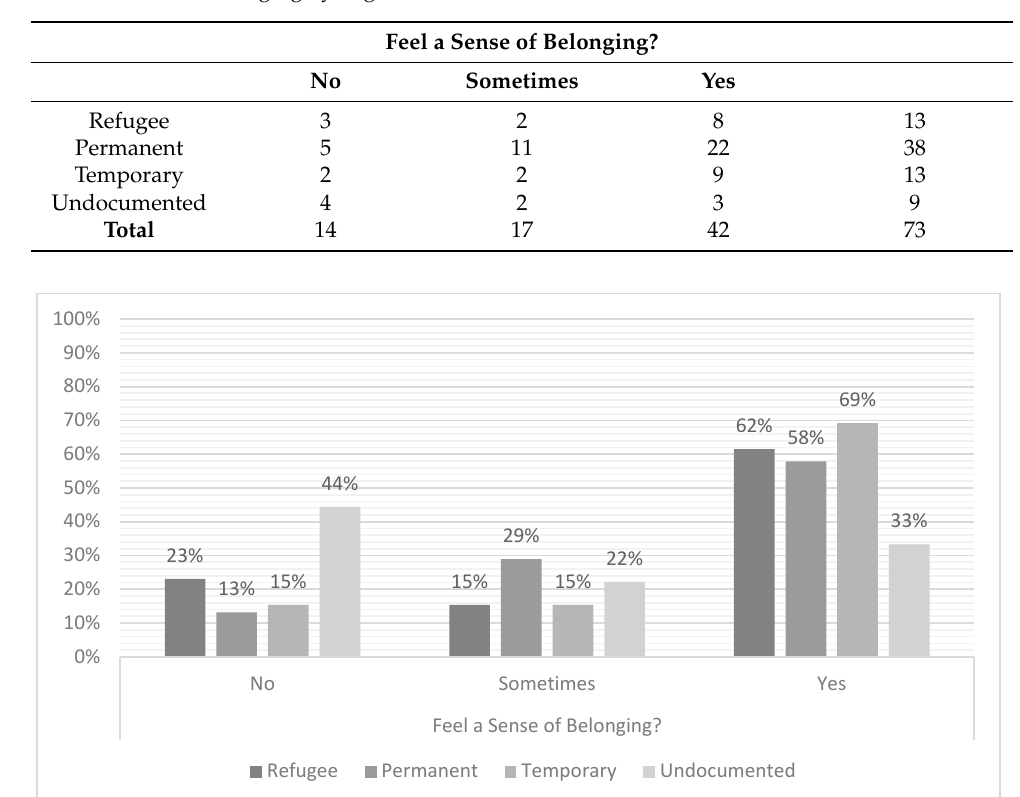
Figure 1. Sense of Belonging by Legal Status within Categories.